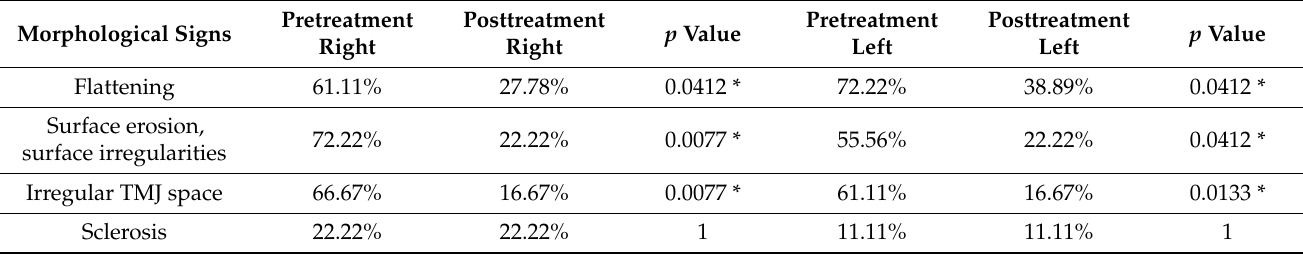
Table 5. Frequency of osseous changes before and after therapy (* p < 0.05).